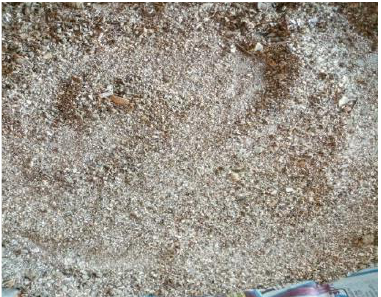
Figure 3a: Sample of crab shell grains (250µm) Figure 3b: Sample of crab shell grains (420µm)